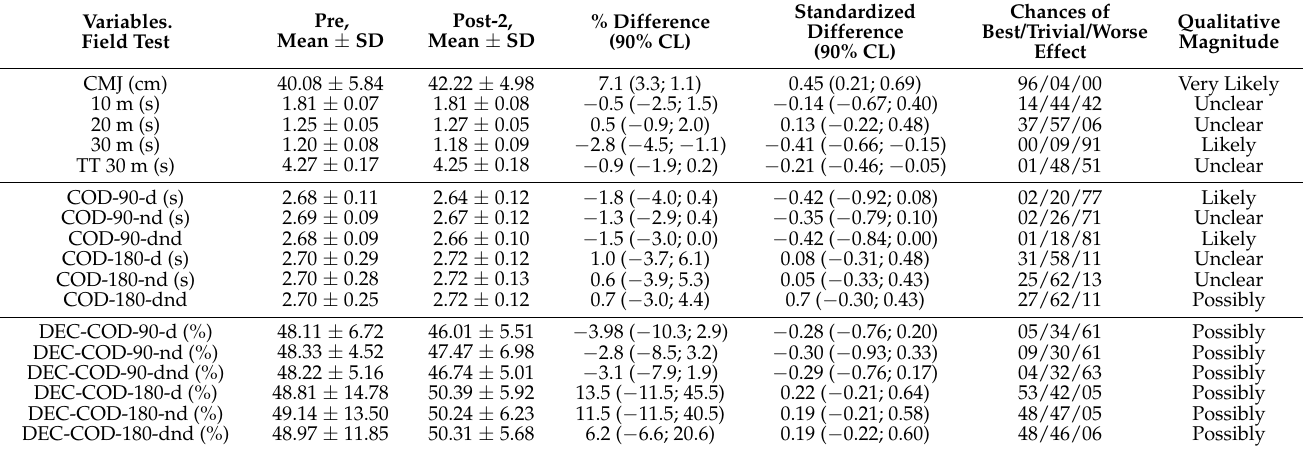
Table 3. Changes in performance after two three-week periods (pre- to post-2) of flywheel